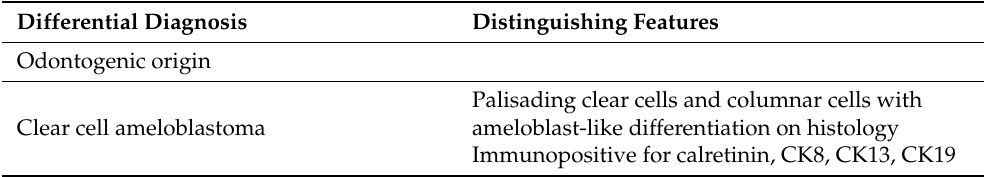
Table 2. Differential diagnoses of